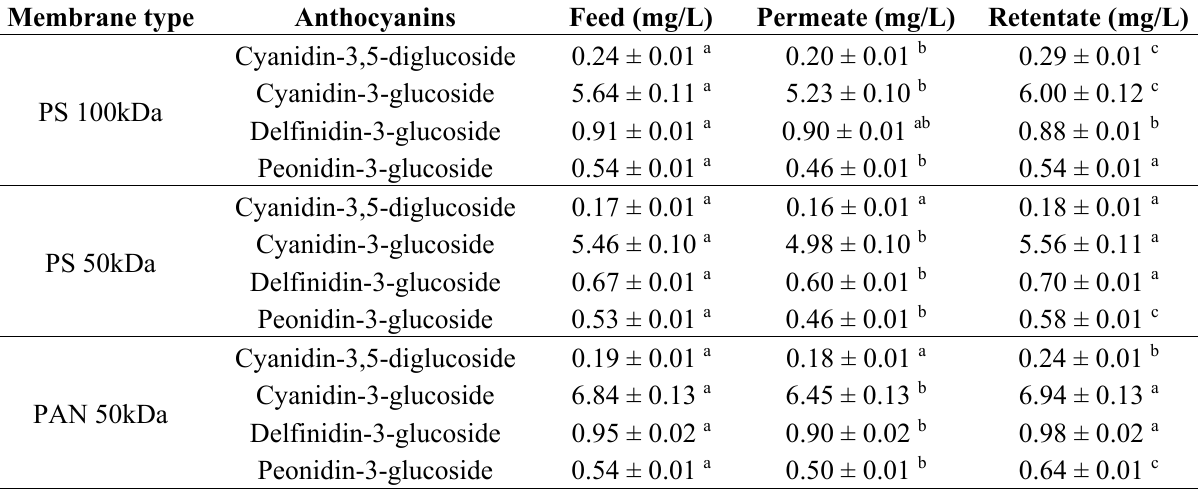
Table 5. Effect of different hollow fiber UF membranes on individual anthocyanins of blood orange